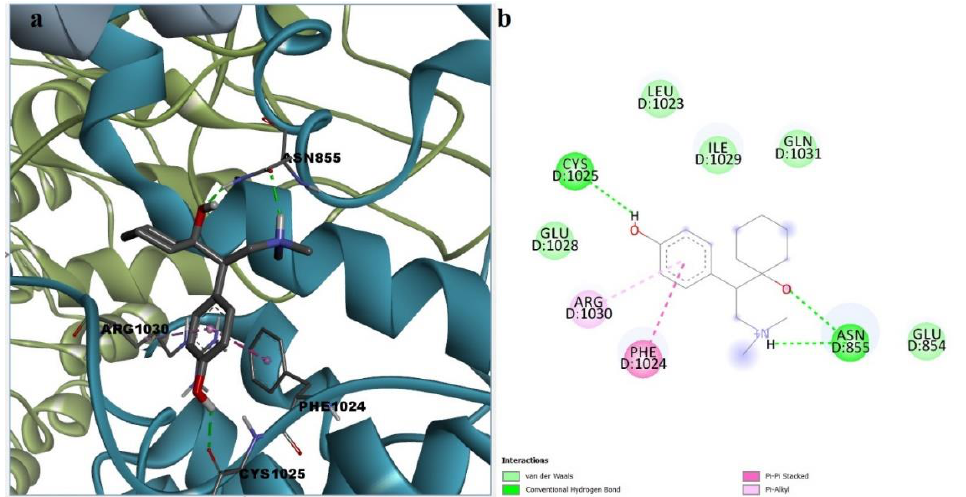
Figure 8. ( a ) 3D binding conformation of desvenlafaxine into putative HC-030031 binding site; ( b )2D diagram of protein-ligand interactions between TRPA1 and desvenlafaxine.